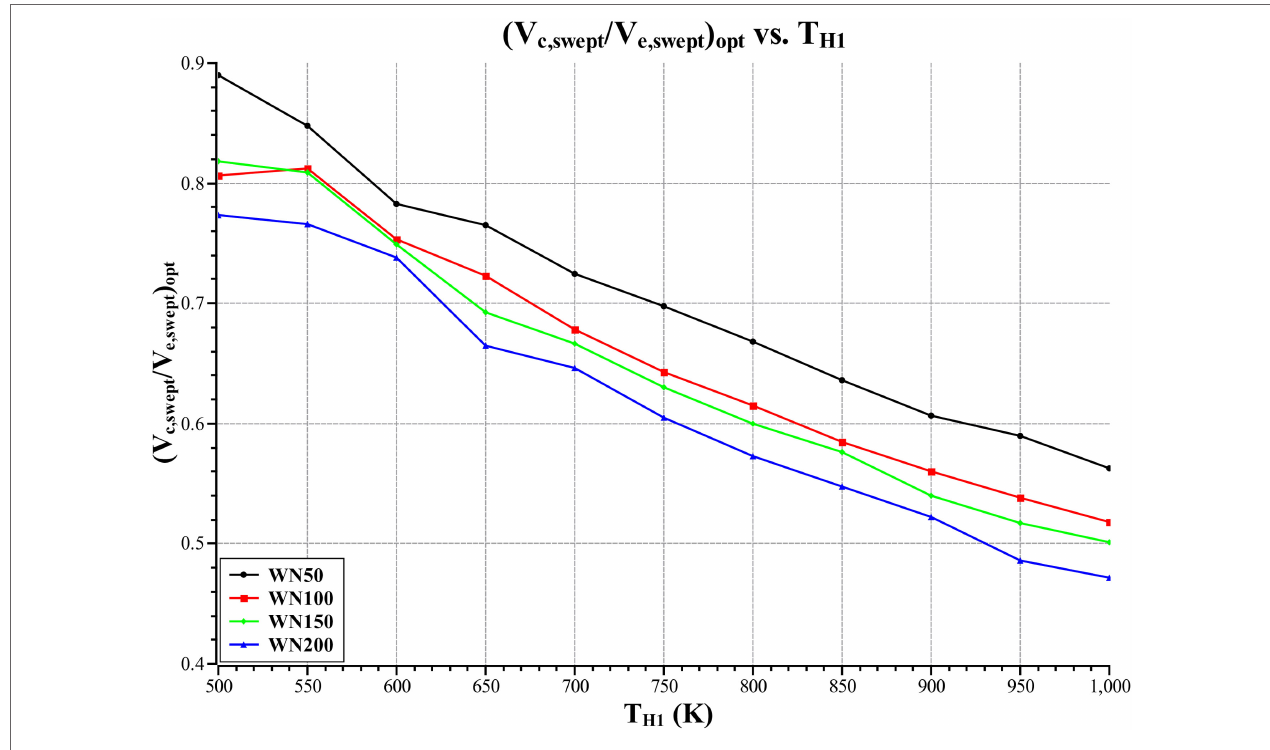
FIGURE 6 | Optimal swept-volume ratio versus heater inlet temperature.